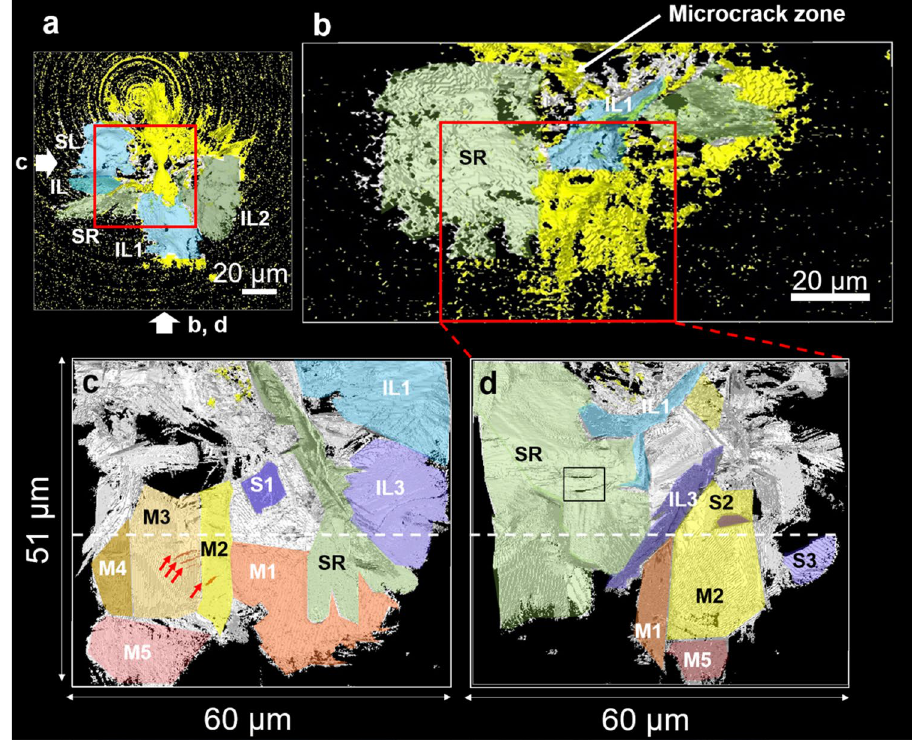
Figure 5. Micro-CT and nano-CT observation of Vickers indentation cracks at 9.8 N load. ( a ) Top view and ( b ) side view of micro-CT image. ( c ) and ( d ) side view of a region-of-interest [ROI, a cube shown as squares in ( a ) and ( b )] observed by nano-CT. Arrows in ( a ) indicate the relative orientation of panels ( b ), ( c ), and ( d ). (SL: Shallow lateral crack, SR: Secondary radial crack, IL: Inclined lateral crack, M: Median crack, S: Single rectangular